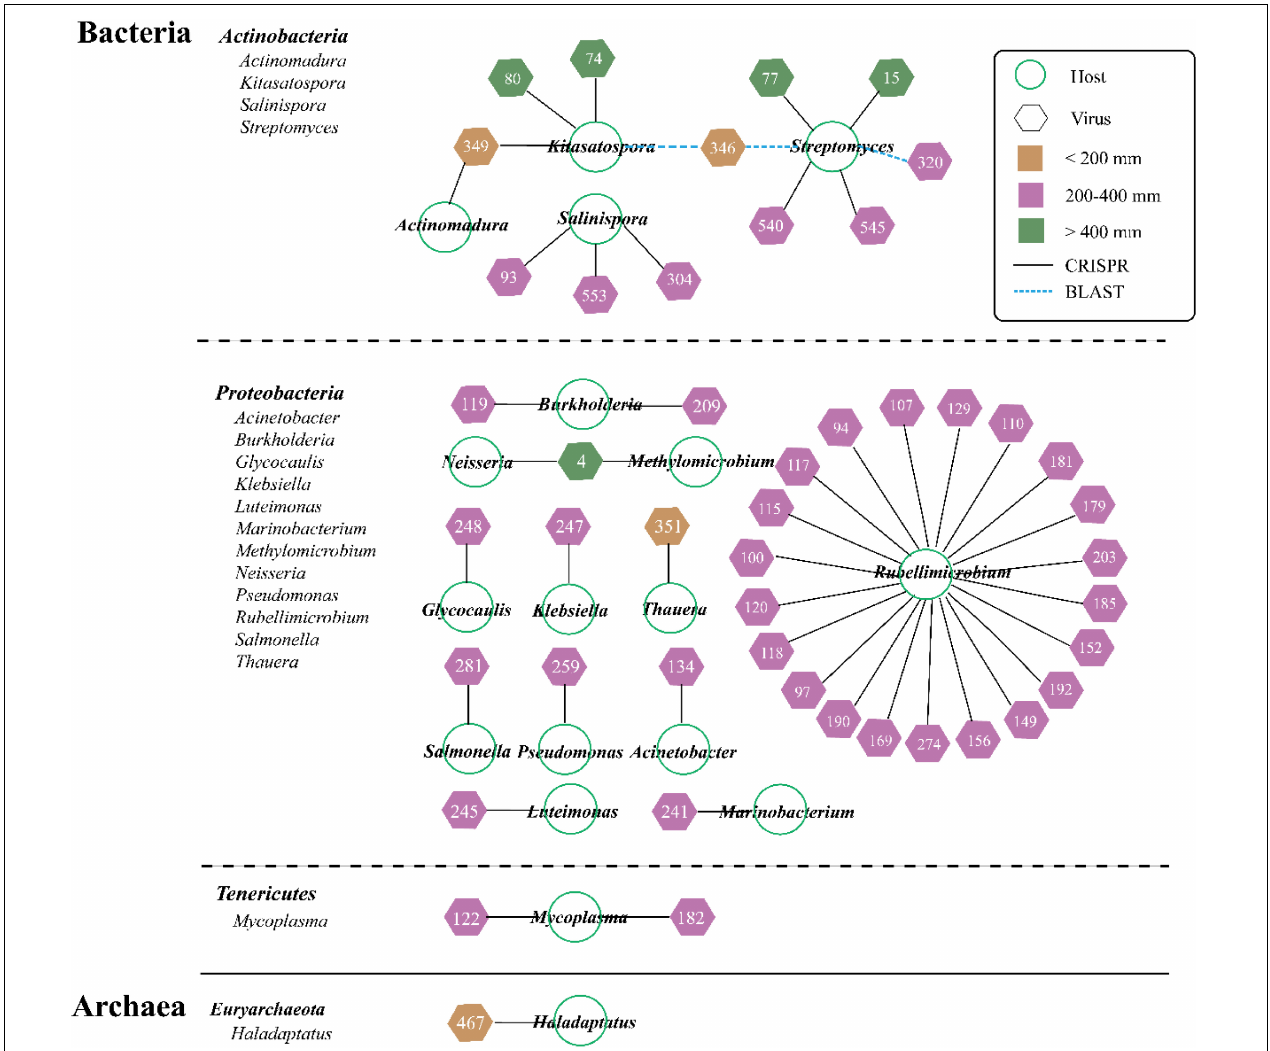
FIGURE 4 | Predicted viral-host linkages under three precipitation gradients. About 47 vOTUs are linked to 4 host lineages by multiple lines of evidence, and the three prediction methods are represented by the different color-coded lines. Node shape denotes organism (circle for microbe and hexagon for virus), and number represents vOTU ( Supplementary Table 2 ). Viral shapes are color-coded by three precipitation gradients (yellow for LP, purple for moderate precipitation, and green for high precipitation).